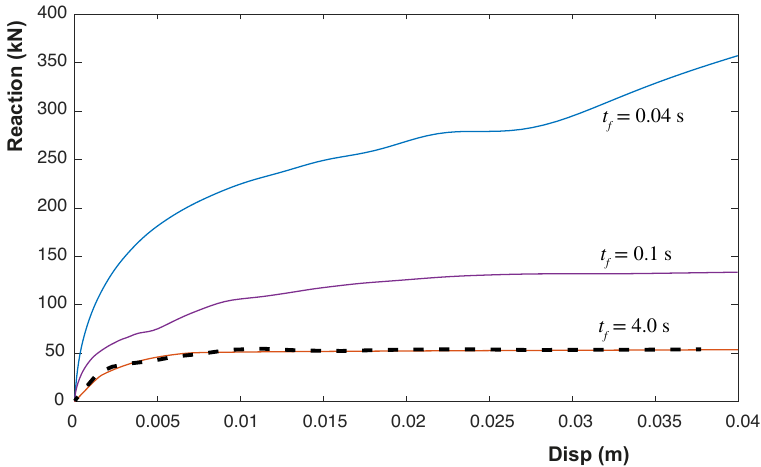
Figure 10. Obtained reaction with different loading rates for the problem of the strip footing using visco-plastic von Mises law, in which t f is the final time of the application of the load. The dashed line represents the pseudo-static